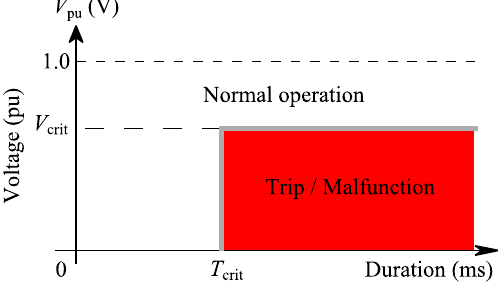
Figure 1. Voltage–tolerance characteristic.